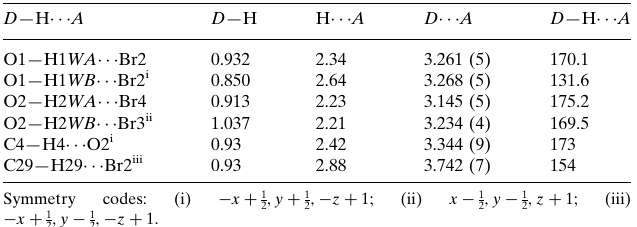
Hydrogen-bond geometry (A˚ , (cid:2) ). D —H (cid:1)(cid:1)(cid:1)